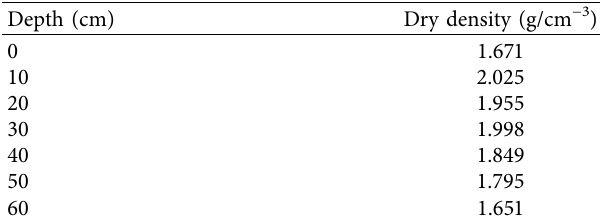
Table 3: Dry densities of the local saline-alkali soil. Depth